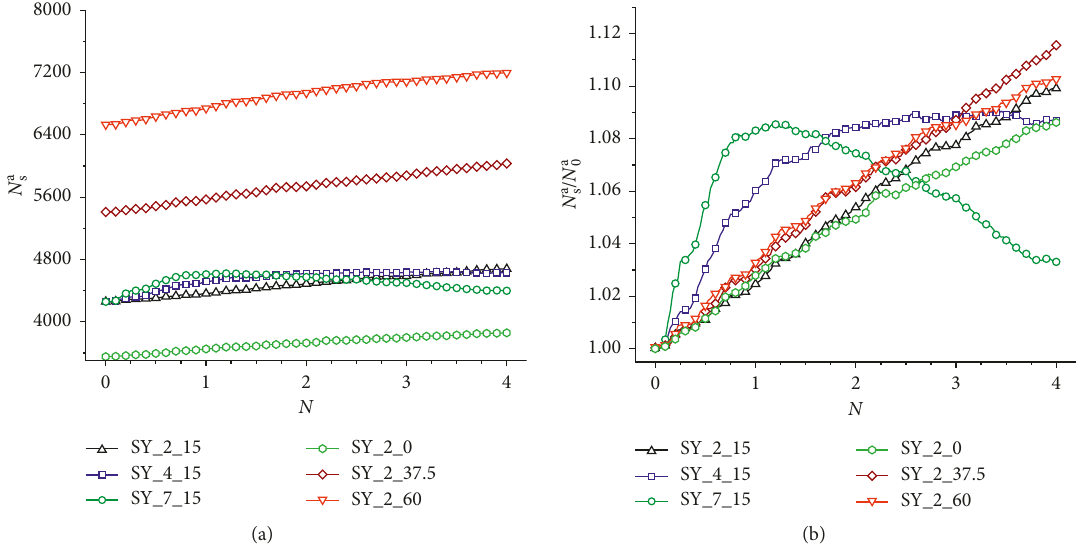
, the number of agglomerates; N a s